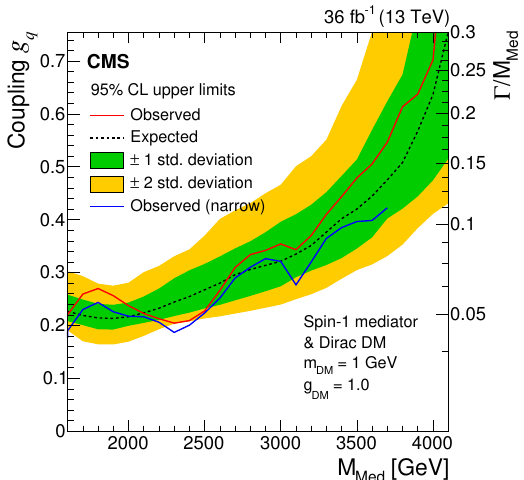
Figure 19 . The 95% CL upper limits on the universal quark coupling g q as a function of resonance mass for a vector mediator of interactions between quarks and DM particles. The right vertical axis shows the natural width of the mediator divided by its mass. The observed limits taking into account the natural width of the resonance are in red(upper solid curve), expected limits (dashed) and their variation at the 1 and 2 standard deviation levels (shaded bands) are shown. The observed limits from the narrow resonance search are in blue (lower solid curve), but are only valid for the width values up to approximately 10% of the resonance mass. The exclusions are computed for a spin-1 mediator and, Dirac DM particle with a mass m DM = 1 GeV and a coupling g DM = 1 :